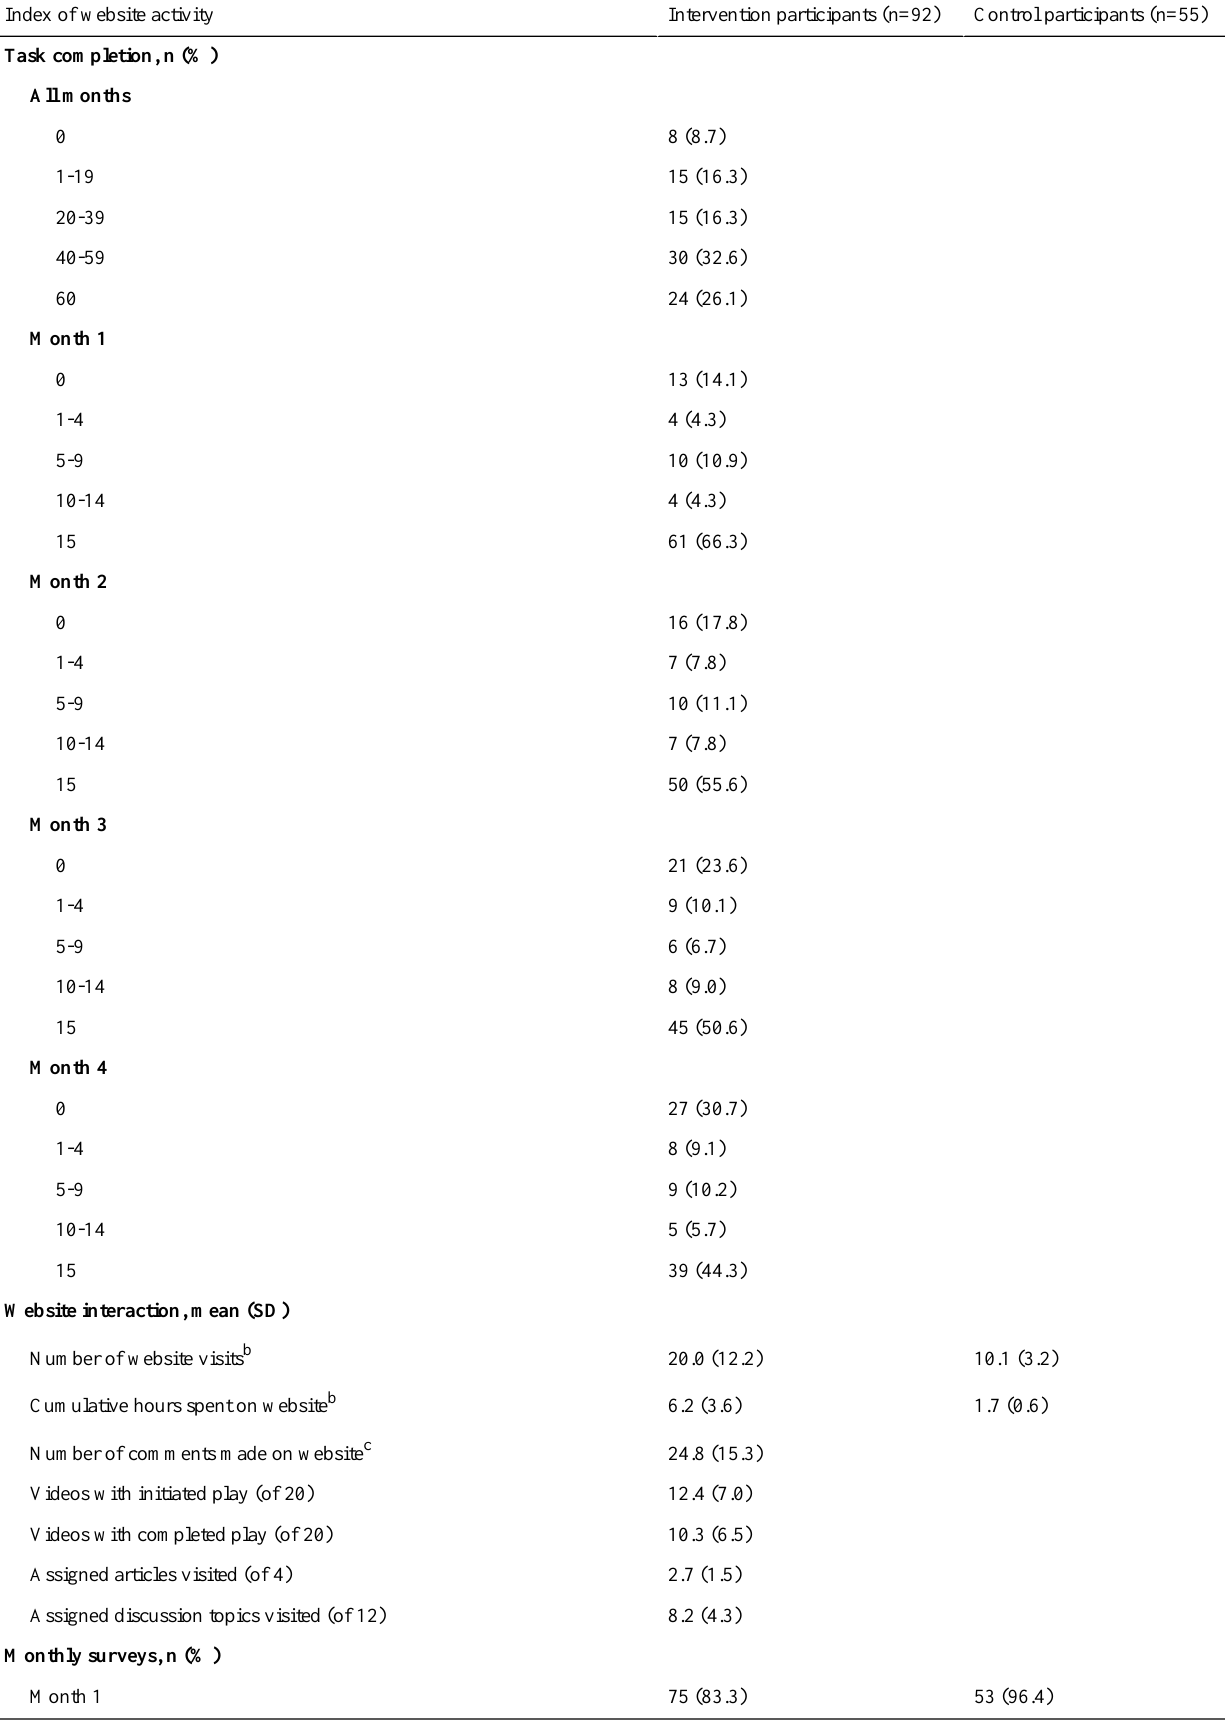
Table 2. Distributions of website activity variables.